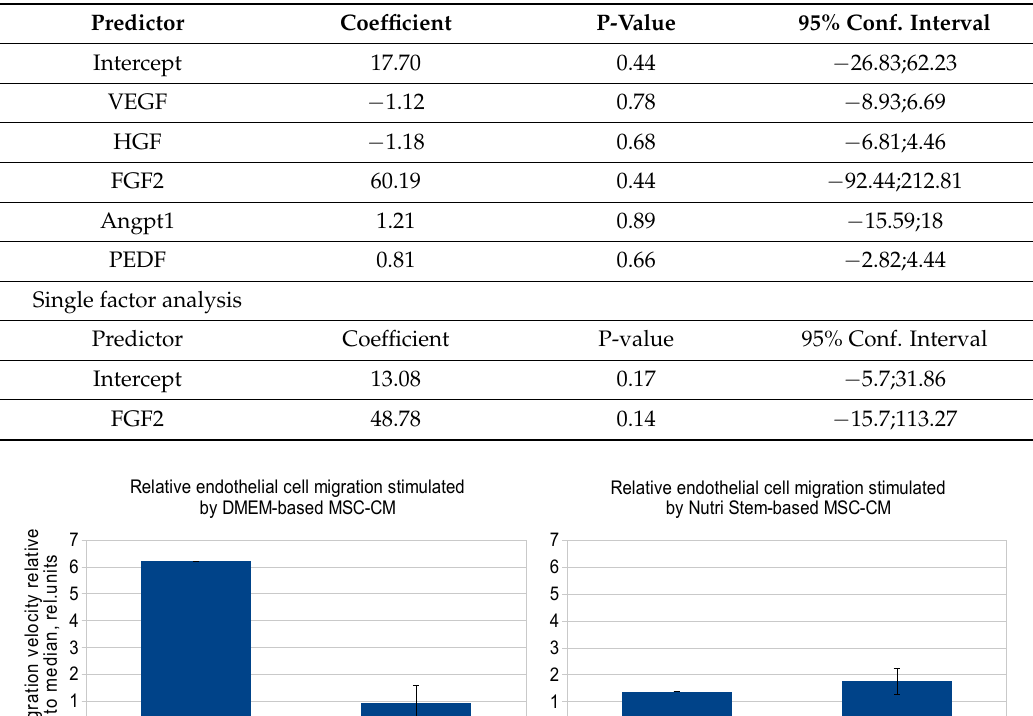
Table 4. Prediction model for DMEM-LG MSC-CM sample potency to stimulate human endothelial cell migration; n = 8 for train group, n = 5 for validation group.